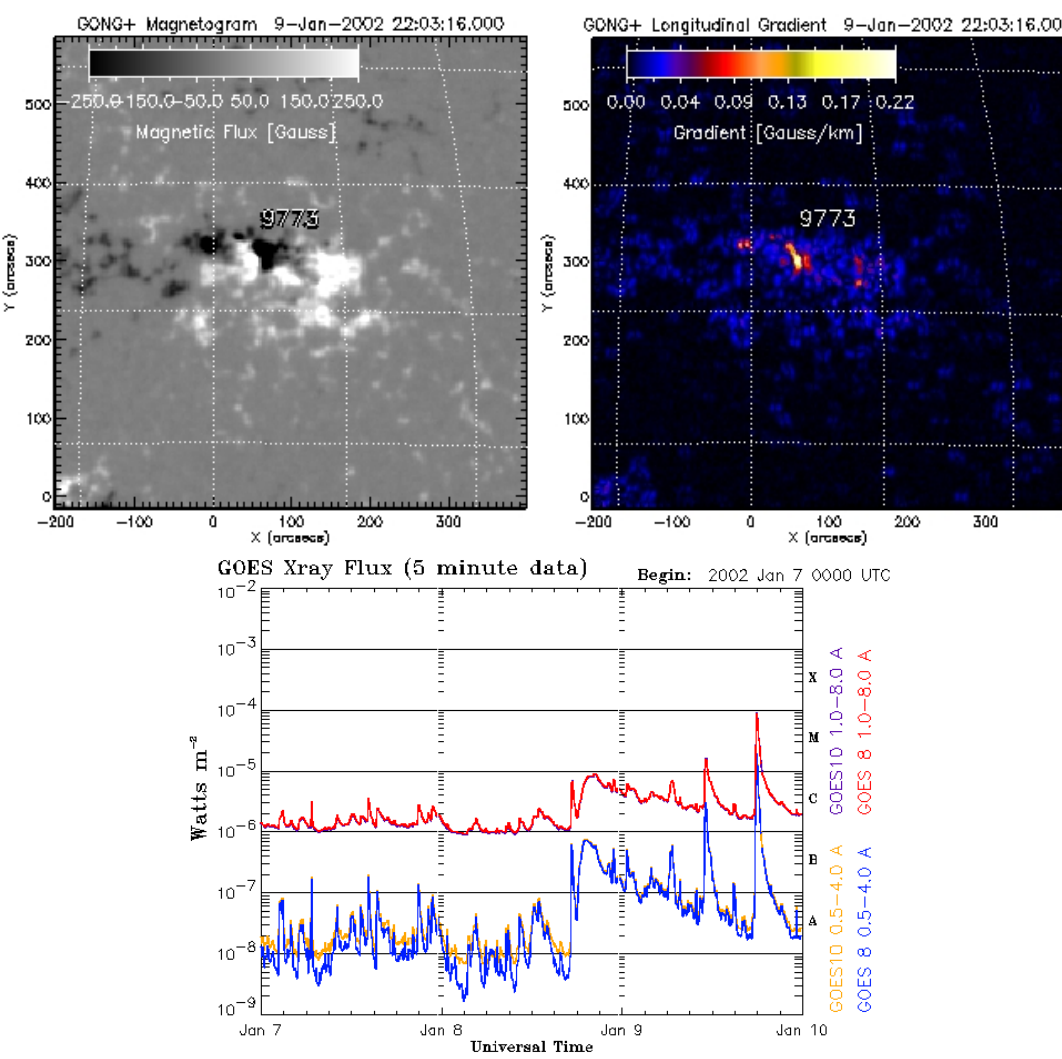
Fig. 6. The top left panel gives a GONG + magnetogram taken at 22:03:16UT on 9 January 2002, while the top right panel gives the gradient of the longitudinal magnetic field. A three-day GOES X-ray plot for 7–9 January 2002 is given at